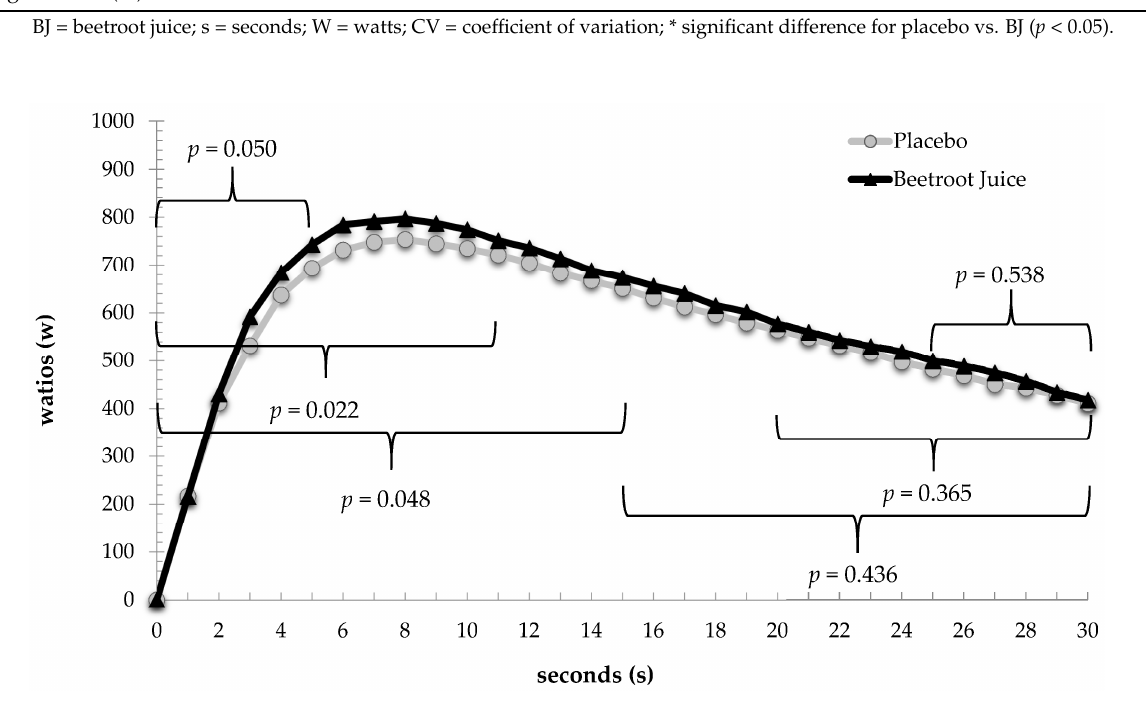
Figure 3. Power curves recorded during the Wingate test in the placebo and beetroot juice supplementation groups. The figure shows that during the first 15 s of the test (0–5 s, 0–10 s and 0–15 s) significant differences in power emerged between the two experimental conditions.